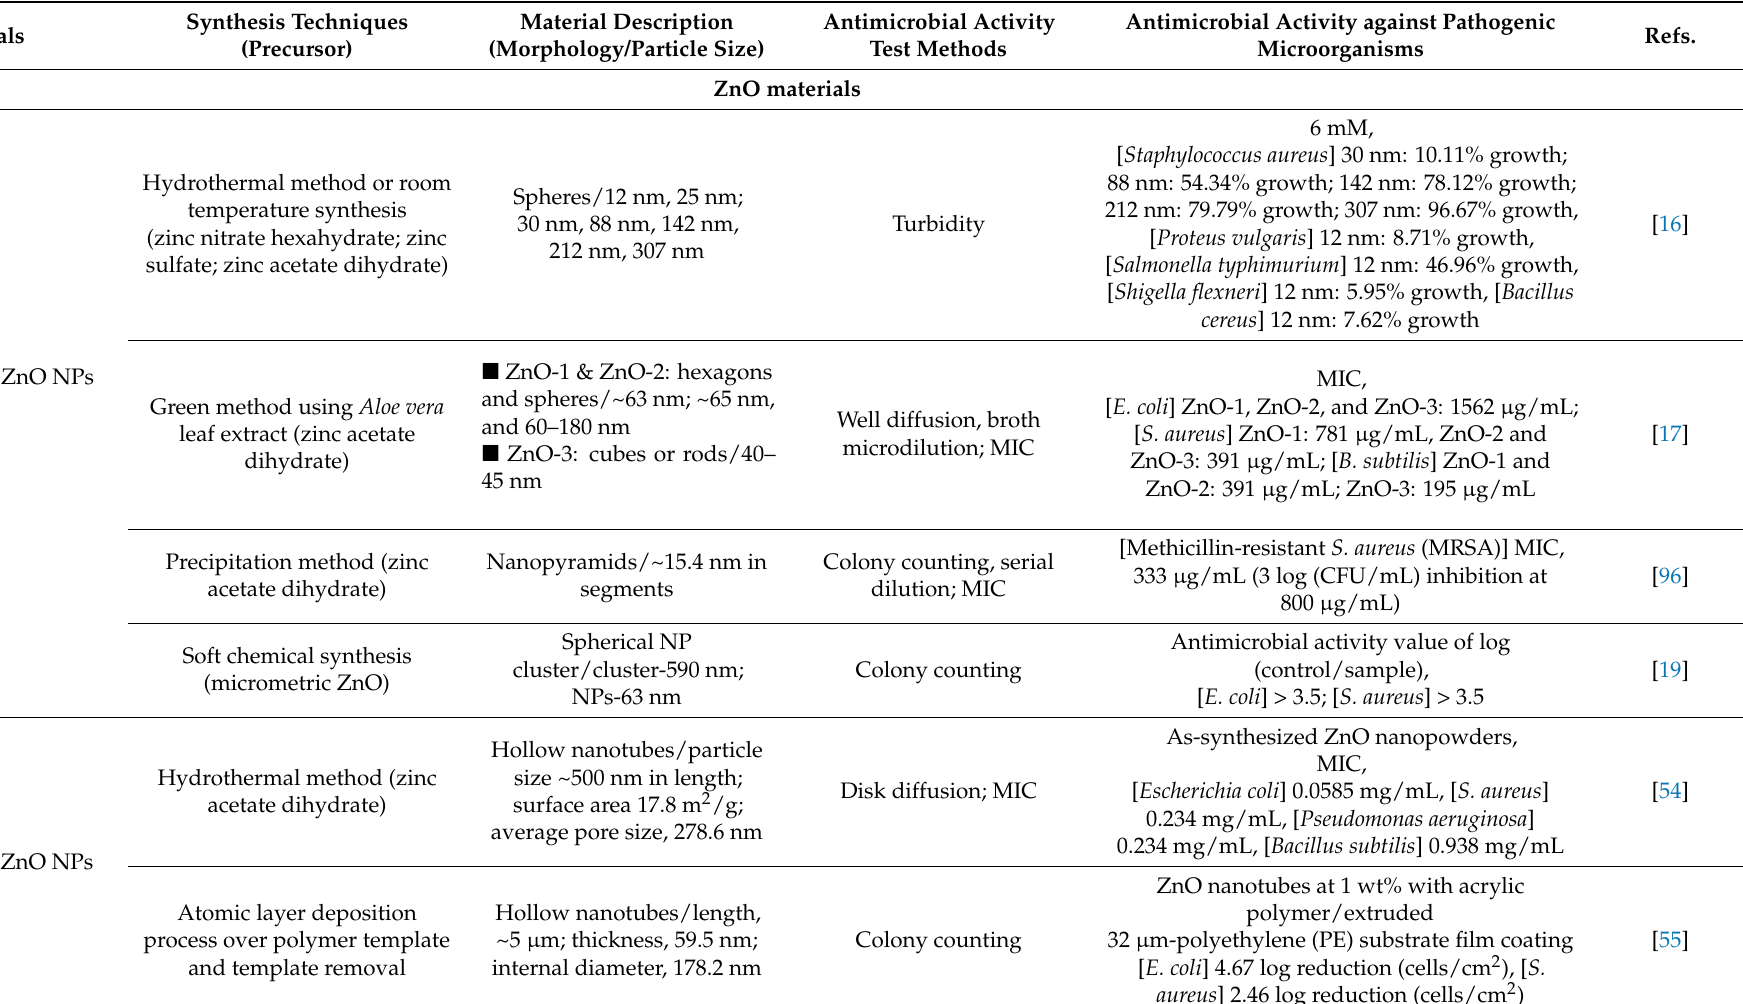
Table 2. Antimicrobial activity of zinc oxide (ZnO) materials against pathogenic